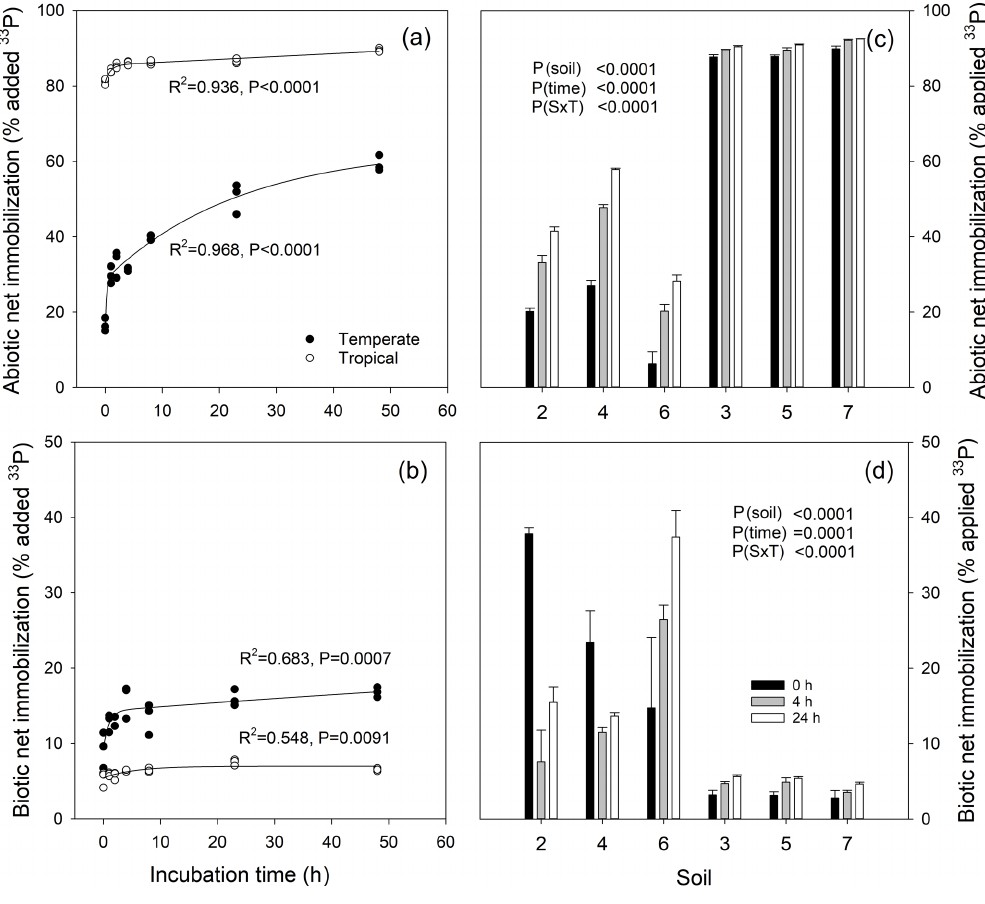
Figure 6. Net immobilization rates of 33 P i by abiotic processes (sorption; a , c ) measured in sterile soils and biotic processes (microbial uptake; b , d ) measured in live soils of a temperate grassland (soil 4) and a tropical forest (soil 3) after 0, 1, 2, 4, 8, 24 and 48h (a, b) and for six soils measured after 0, 4 and 24h (c, d) . Temperate grassland soils (2, 4 and 6) and tropical forest soils (3, 5 and 7) were investigated in (c) and (d) . Curvilinear regressions following the function “exponential rise to maximum” were performed on the data in (a, b) . Statistical analyses of data in (c, d) were undertaken using a two-way ANOVA for the factors soil and time (0, 4 and 24h after tracer addition), and the interaction between factors.